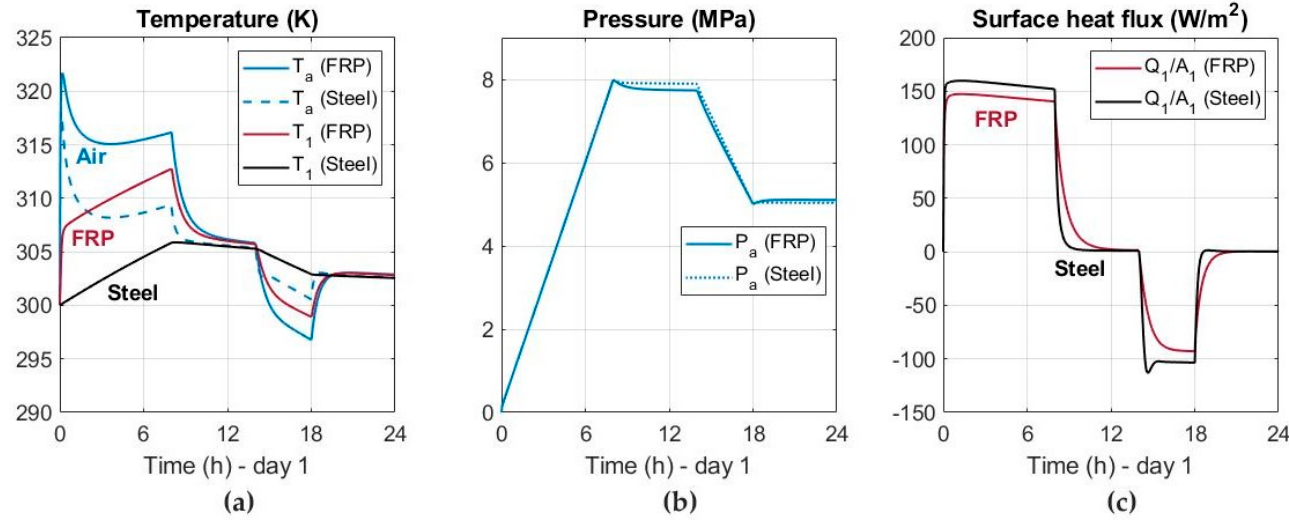
Figure 7. Comparative analysis between FRP and steel in the first cycle. ( a ) Temperature of air, FRP and steel; ( b ) Air pressure; ( c ) Surface heat flux of FRP and steel.